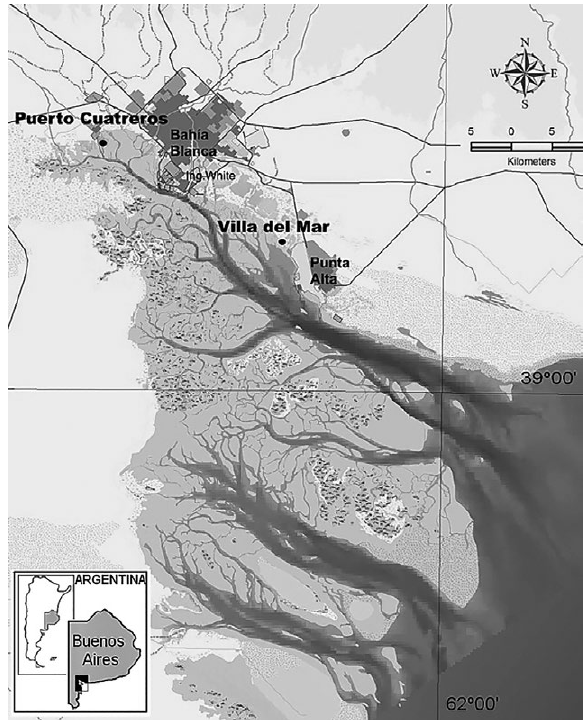
Fig. 1. – The Bahía Blanca estuary, highlighting the sampling sites: Villa del Mar and Puerto Cuatreros.